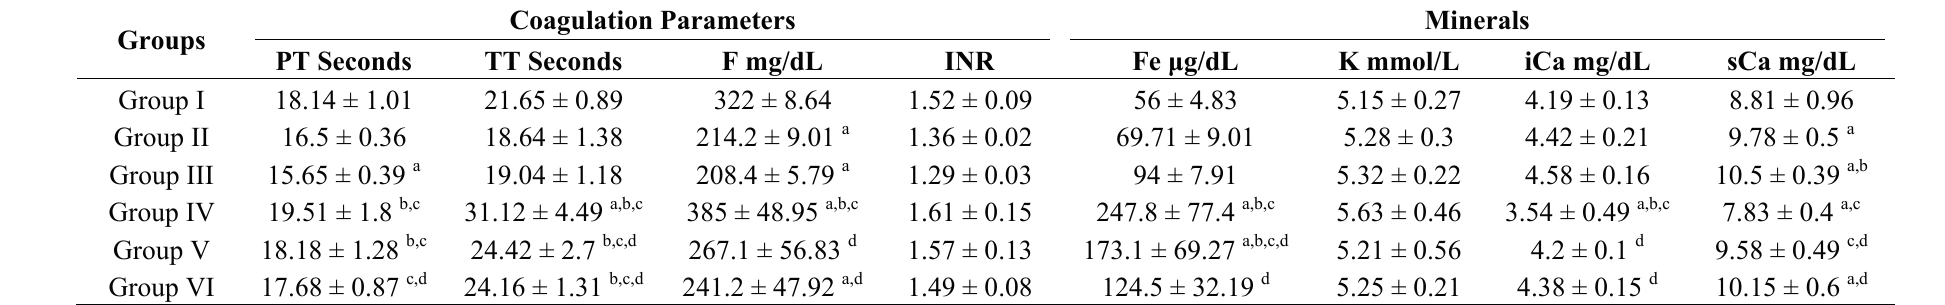
Table 6. Coagulation parameters and minerals